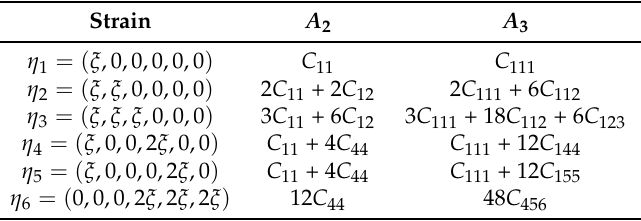
Table 1. The coefficients A 2 and A 3 in Equation (5) of the corresponding selected strain tensors as the linear combinations of the second- and third-order elastic constants for cubic crystal